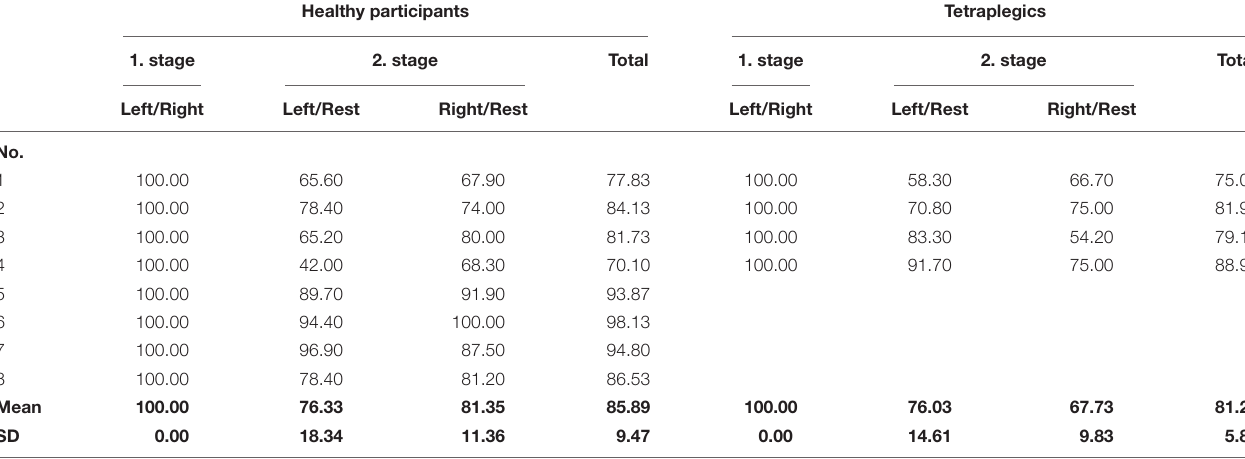
TABLE 2 | Accuracy of bilateral electroencephalography/electrooculography (EEG/EOG) brain/neural exoskeleton control. Healthy participants Tetraplegics